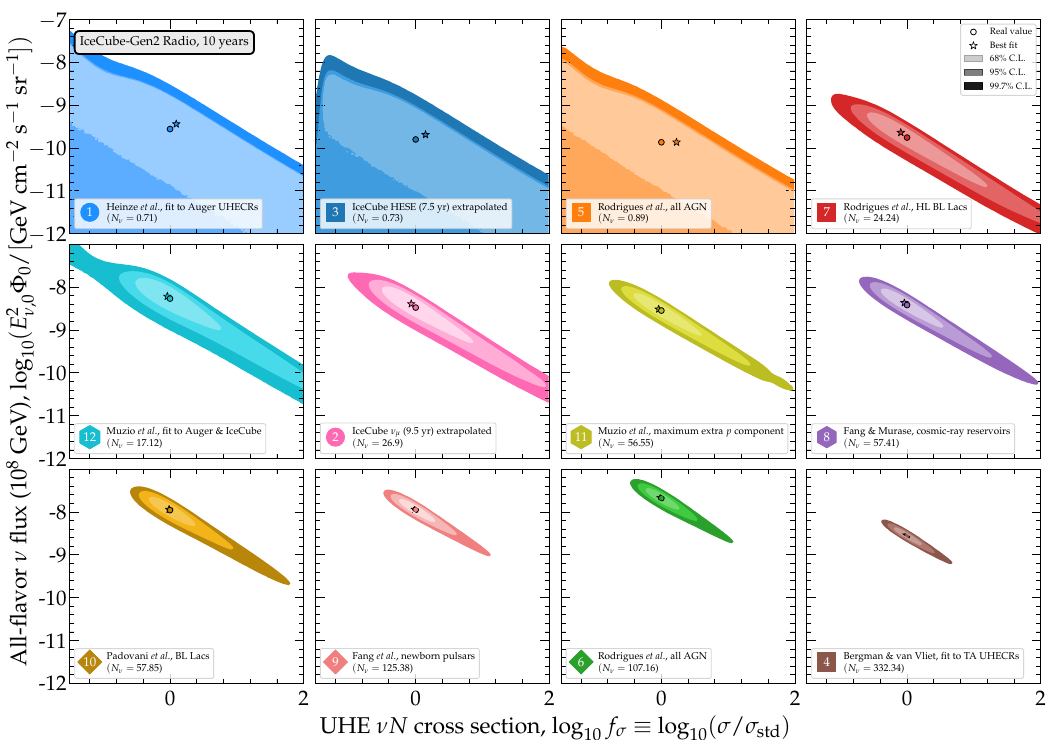
Figure 22 . Same as figure 17 in the main text, but for all the benchmark UHE neutrino flux models adopted in our analysis; see section